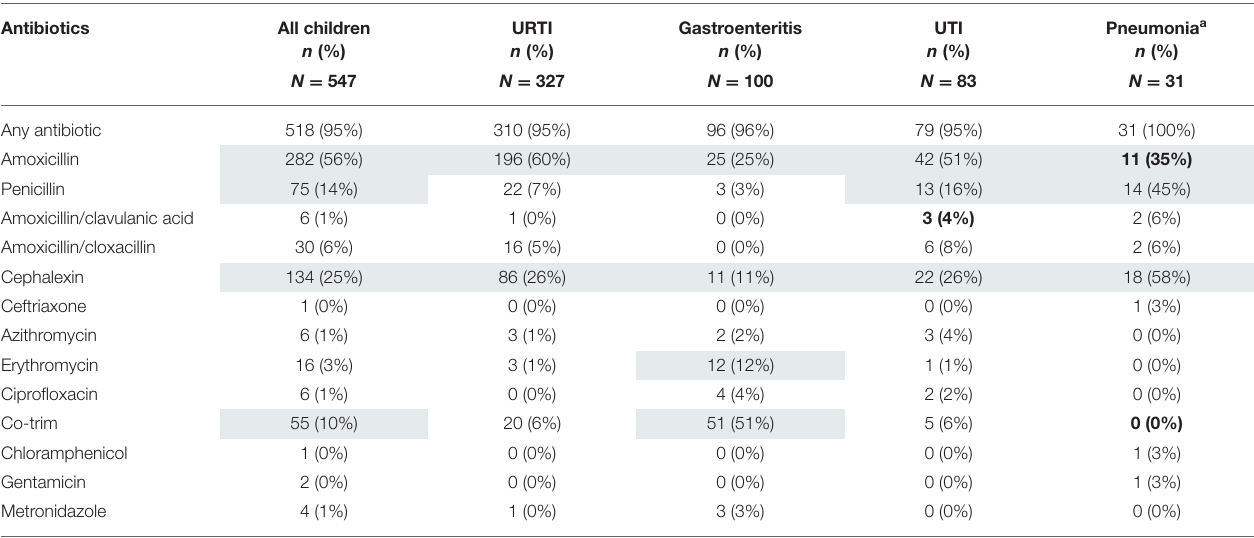
TABLE 5 | Treatments prescribed. (A) Antibiotics prescribed in all children, and per diagnosis Antibiotics